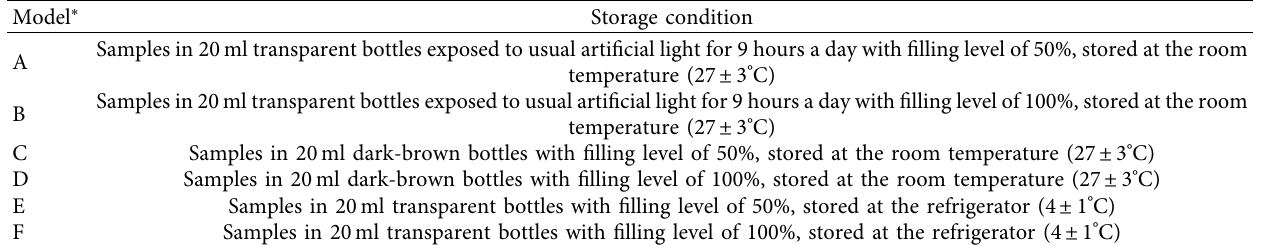
Table 2: Storage conditions for fortified oil samples.